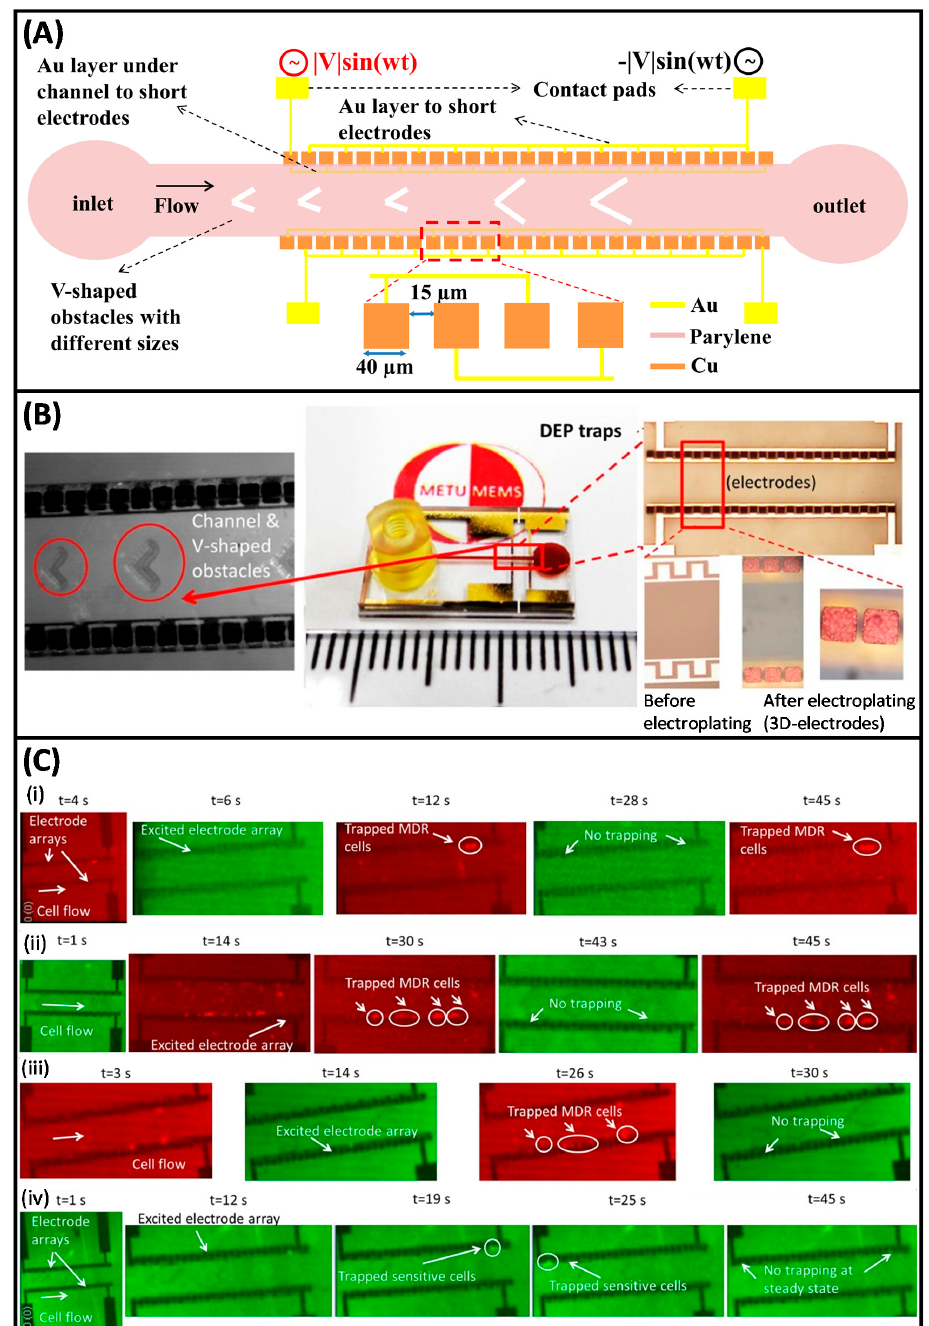
Figure 4. The schematic ( A ) and fabricated ( B ) version of the DEP-based multidrug resistance (MDR) detection device. ( C ) Pseudo colored screenshot images of trapped K562/doxR ( i ) and K562/imaR ( ii ) cells taken at a flow rate of 6.67 μ L/min. ( iii ) The separation of K562/imaR cells and wild type K562 cells under 10 μ L/min flow rate to make flow rate performance analysis. Working solution was the mixture of K562/imaR and wild type K562 cells with 2.5 × 10 3 cells/mL and 2.5 × 10 5 cells/mL, respectively (f = 48.64 MHz, V = 9 V pp ). ( iv ) The screenshots taken during the analysis of wild type K562 cells only. No cell was trapped until t=12 s. Some of the cells were trapped during the experiment. At the end of 45 s, required duration to reach steady state in channels, all cells were carried away [182]. Copyright 2015, John Wiley and